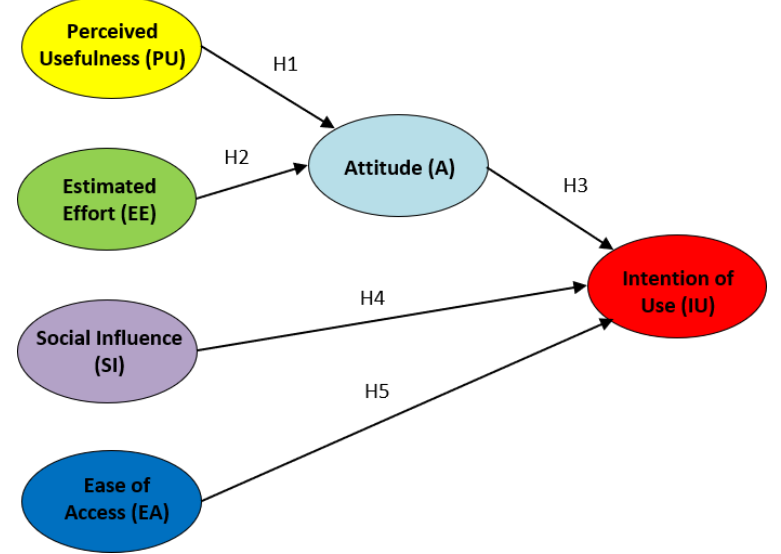
Figure 2. UTAUT structural model and hypotheses (H1, H2, H3, H4,